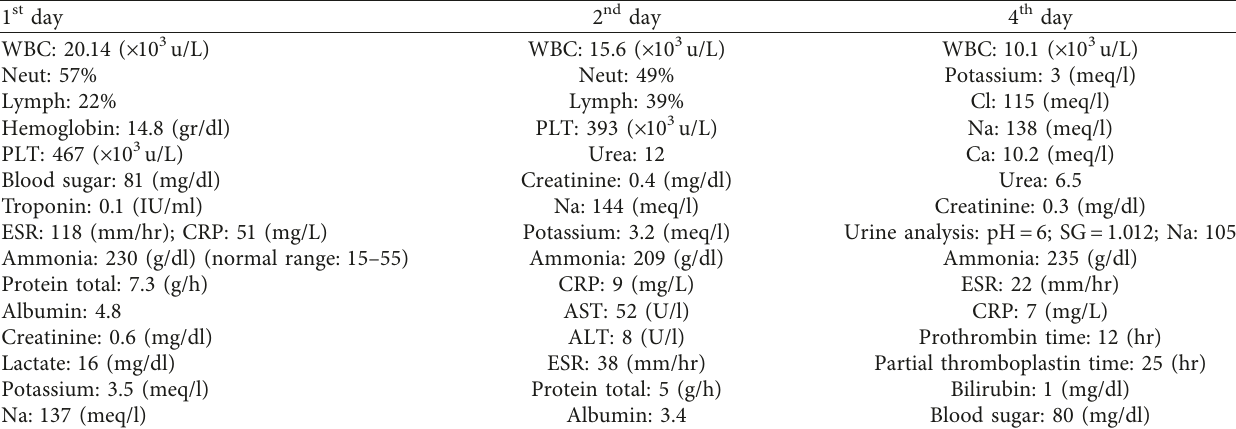
Table 1: Laboratory tests of the patient during